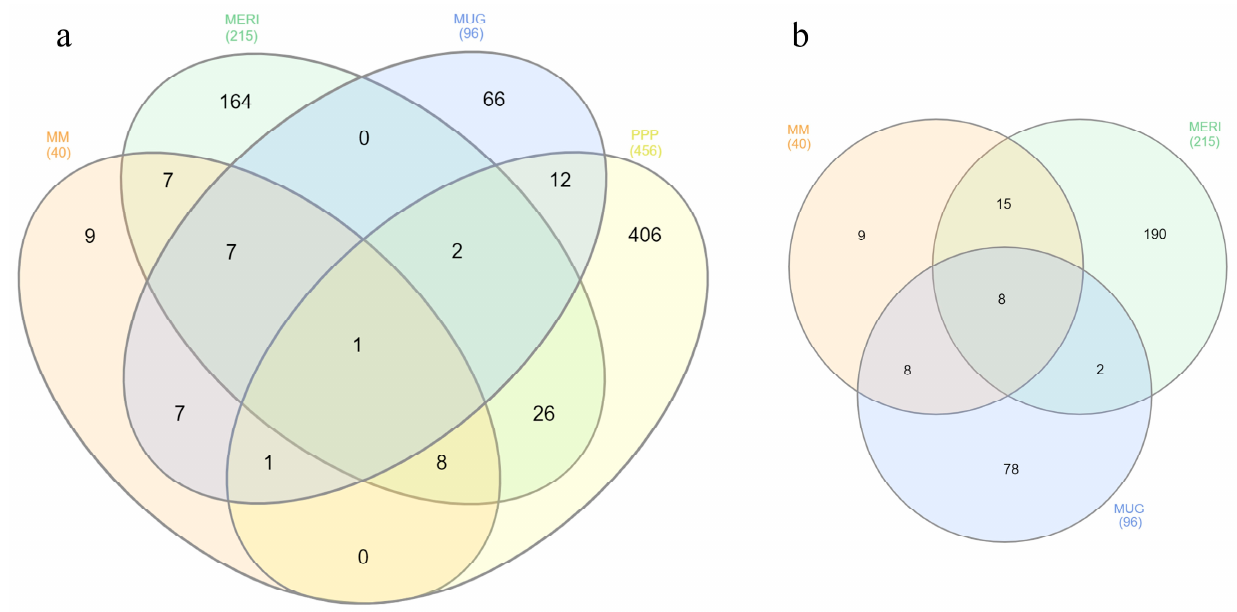
Figure 4. Venn diagrams of the annotated genes with significant variants from the GWAS analyses. ( a ) Venn diagram from the meta-analysis (MM), Mericanel della Brianza (MERI), Mugellese (MUG), and Pepoi (PPP) breeds and the ( b ) Venn diagram representing genes from the MM, MERI, and MUG breeds.